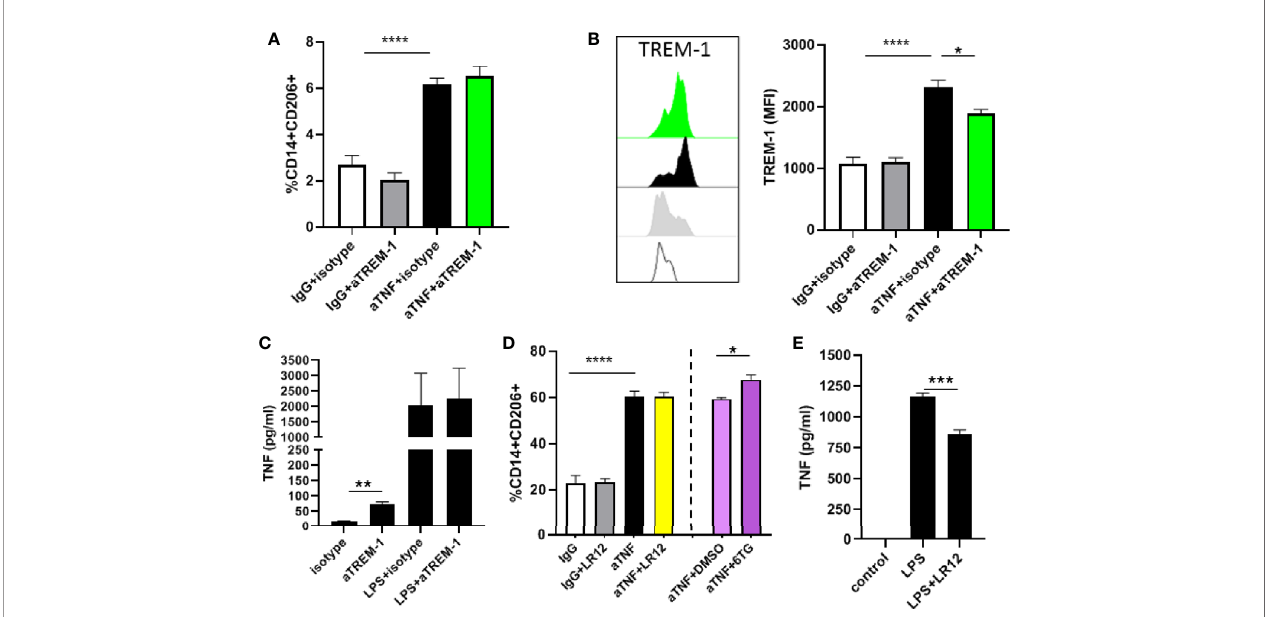
FIGURE 2 | TREM-1 signaling does not affect anti-TNF induced differentiation of regulatory type macrophages. (A) Percentage of CD206+CD14+ cells in a mixed lymphocyte reaction with anti-TNF (adalumimab, 10 µg/ml), IgG isotype control (10 µg/ml) in combination with the agonistic TREM-1 antibody or relevant isotype control (both 10 µg/ml). (B) TREM-1 MFI of the CD14+CD206+ population in the MLR. (D) Percentage of CD206+CD14+ cells in a mixed lymphocyte reaction with anti-TNF, IgG isotype control in combination with the TREM inhibitor LR12 (50 µg/ml), and 6-TG (25 µM) or DMSO control. TNF a production by monocytes stimulated for 24 hours with the agonistic TREM-1 antibody (10 µg/ml) in (C) and with LPS (100 ng/ml) in combination with LR12 (50 µg/ml) in (E) . Representative (n=3-5 per condition) of 3 to 4 different independent experiments using different donors. Signi fi cance was determined by ANOVA followed by Sidak ’ s multiple comparison test in A/B/D and unpaired t-test in C/E with *P < 0.05, **P < 0.01, ***P < 0.001 and ****P <